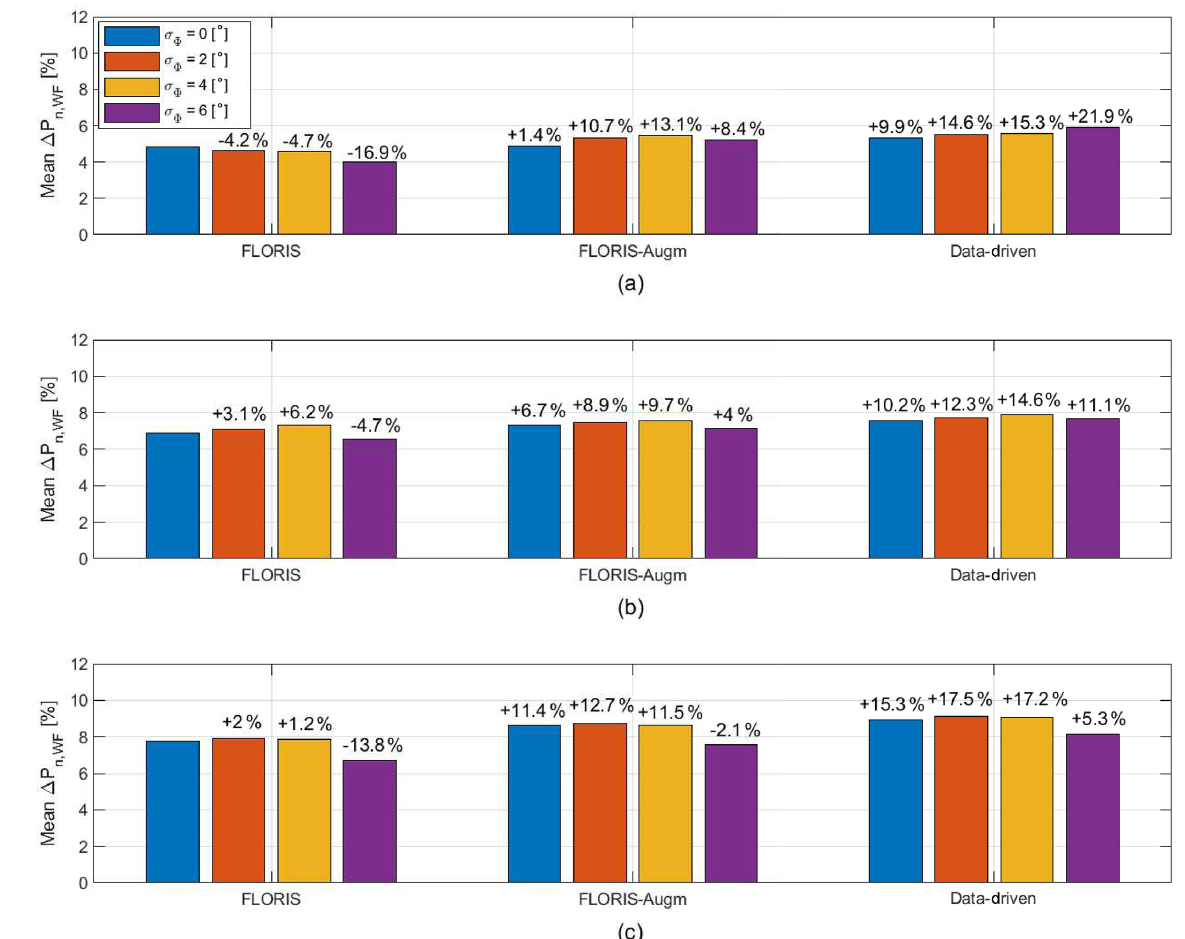
Figure 16. Overall power gains for the three models of different fidelity and increasing robustness of the LUTs: (a) experimental results, (b) simulations with γ Meas , and (c) simulations with γ ∗